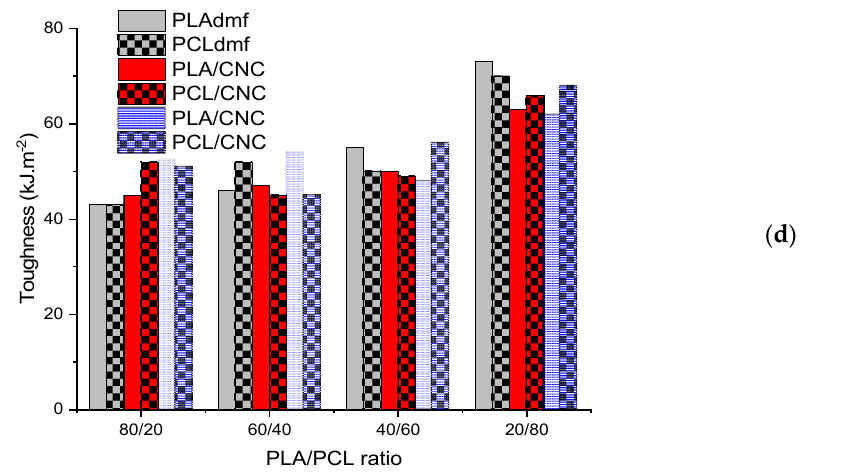
Figure 5. Mechanical properties: ( a ) Young’s modulus; ( b ) tensile strength; ( c ) elongation; ( d ) tensile impact strength.